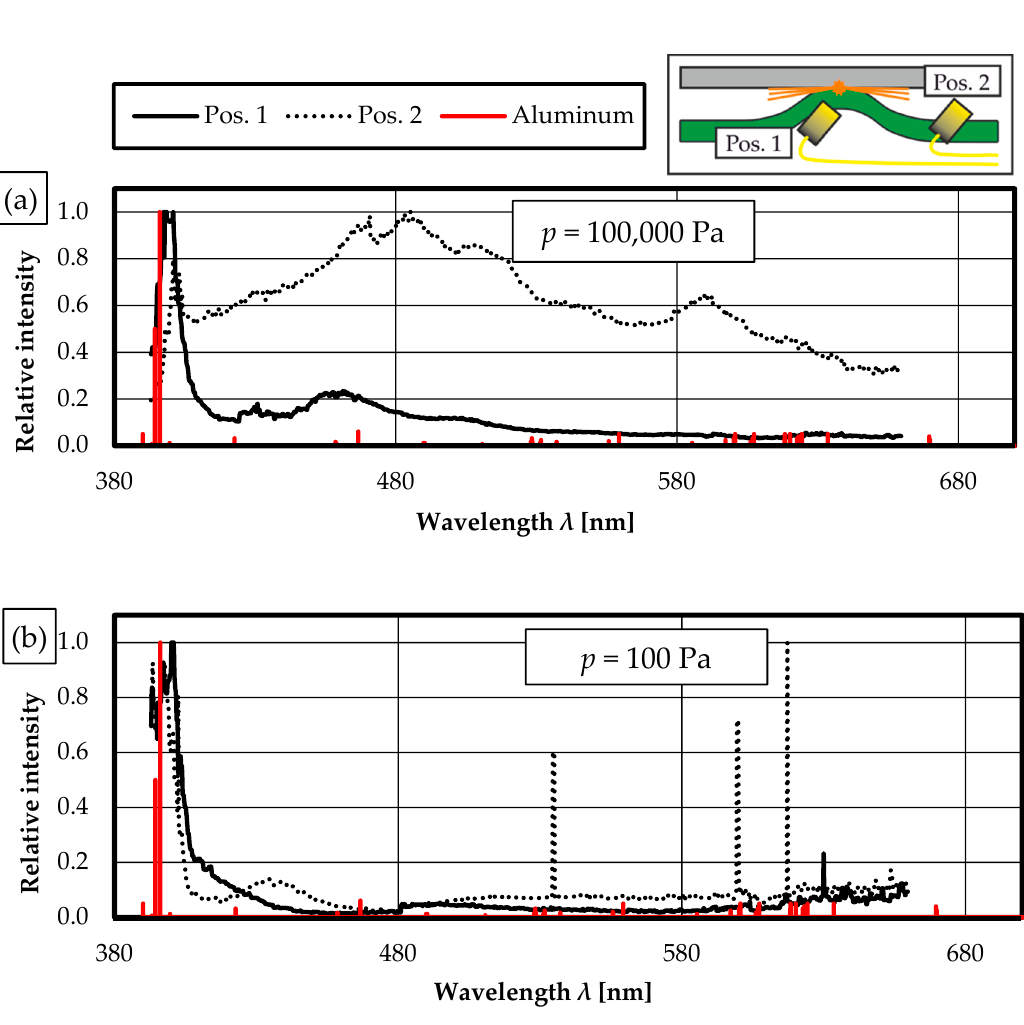
Figure 11. Relative spectral intensities obtained at constant impact velocity v imp ≈ 243 m / s at two different positions under ( a ) normal ambient pressure and ( b ) reduced pressure 100 Pa in comparison with the characteristic aluminum emission lines [42].